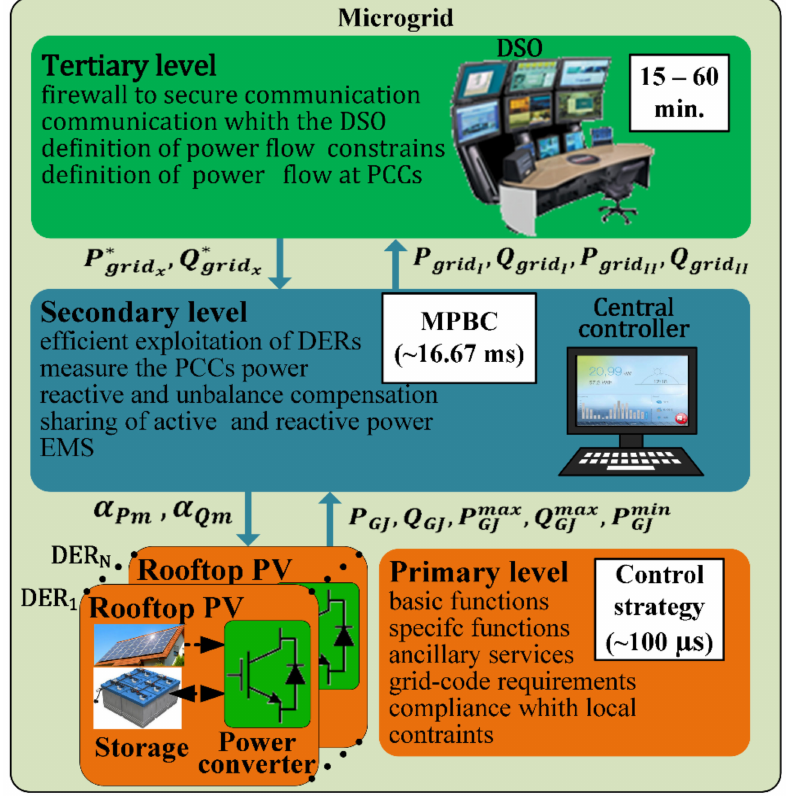
Figure 2. Hierarchical control